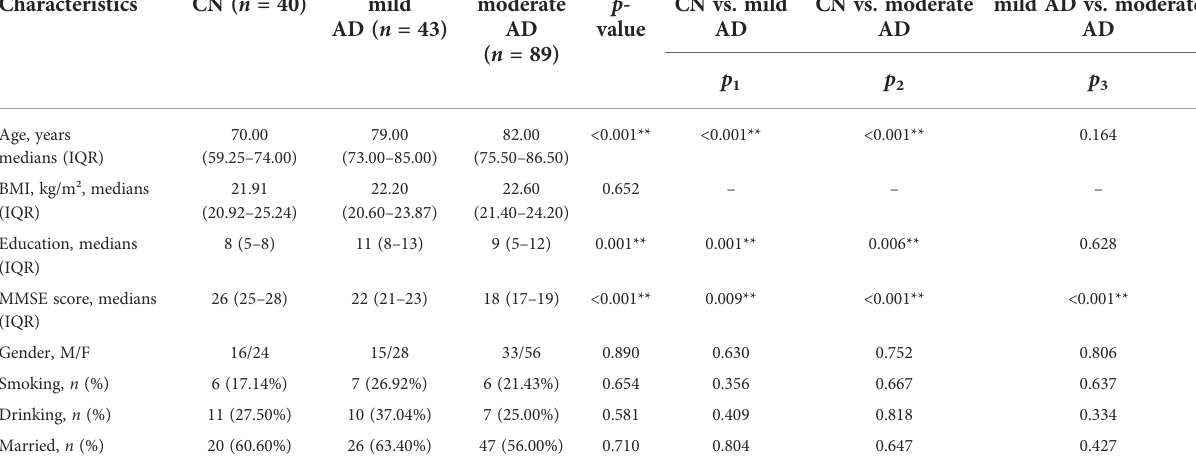
TABLE 1 General characteristics of